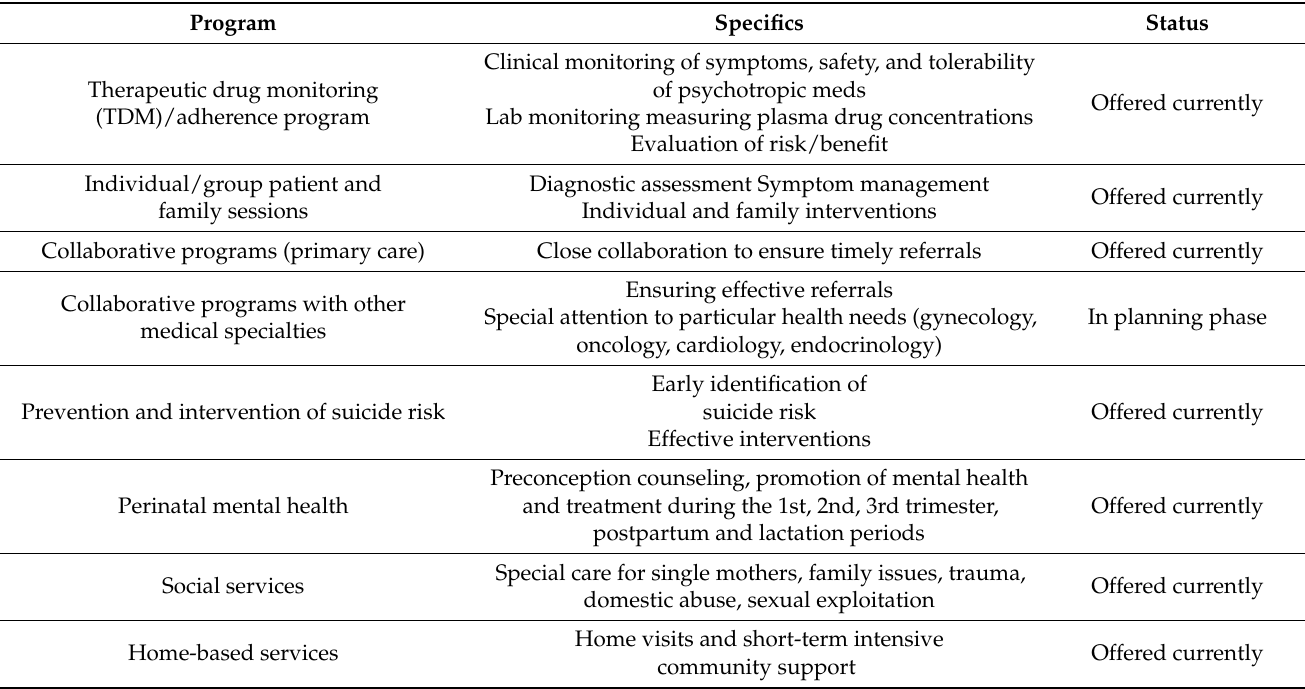
Table 1. Currently offered and projected programs in the unit for women with